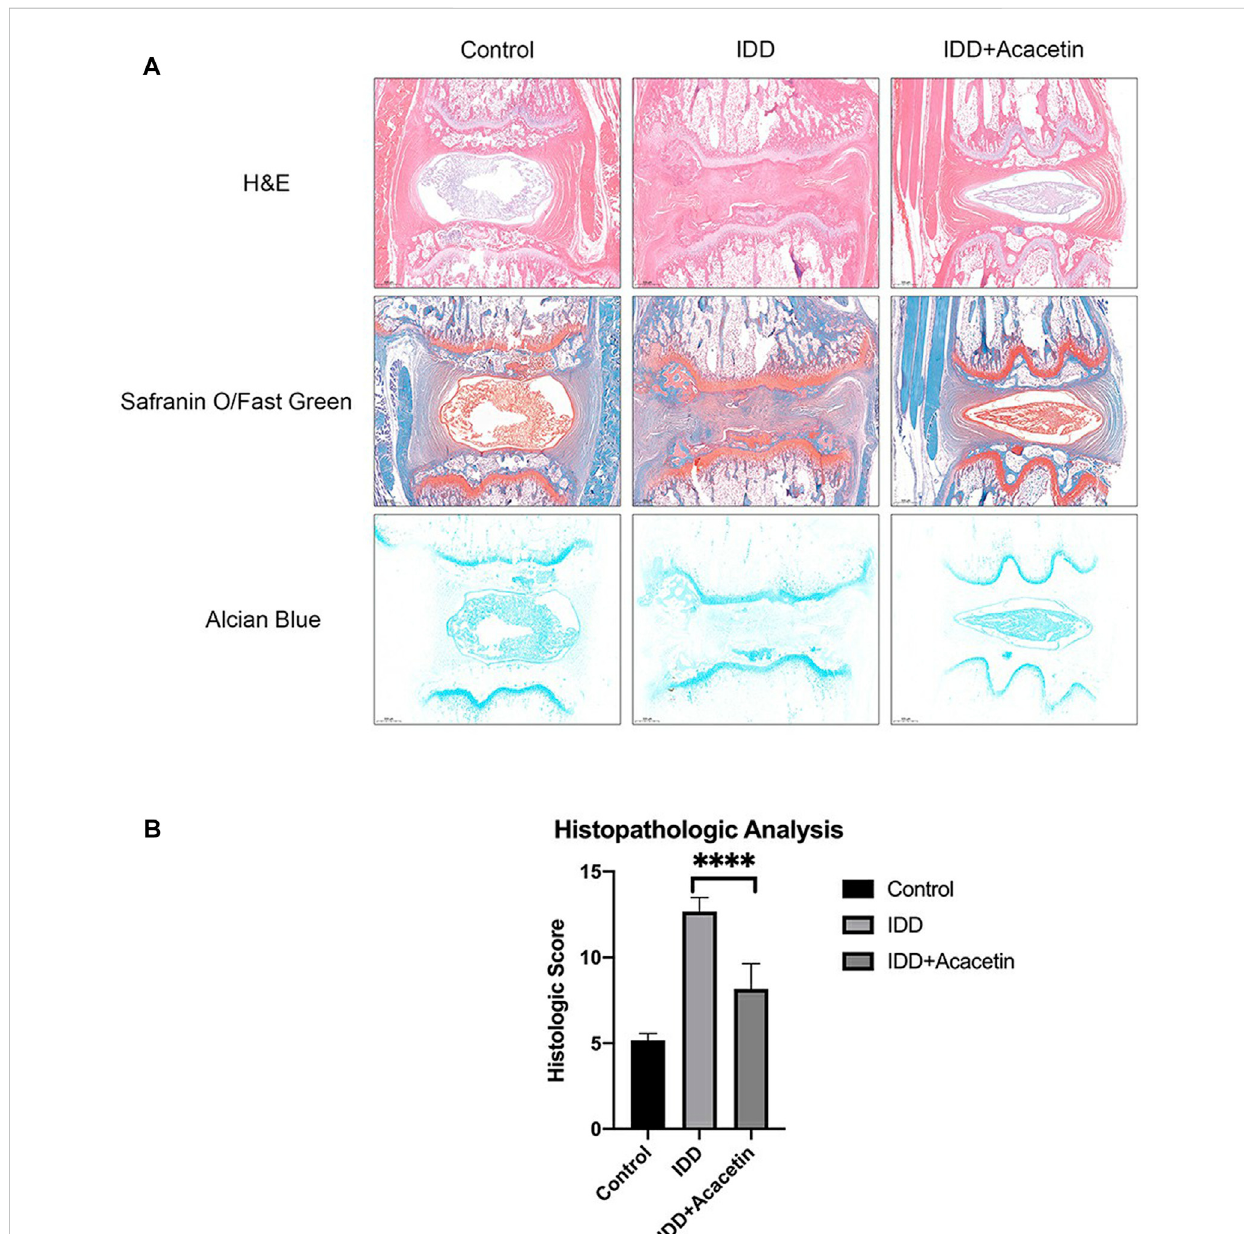
FIGURE 5 Images of IVD from rats in each treatment group stained with Safranin O/Fast Green and Alcian Blue in each group (A) A comparison of histological scores in each group (B) , “ **** ” p < 0.0001. Reproduced with permission from a previous publication (Wang et al., 2020b).